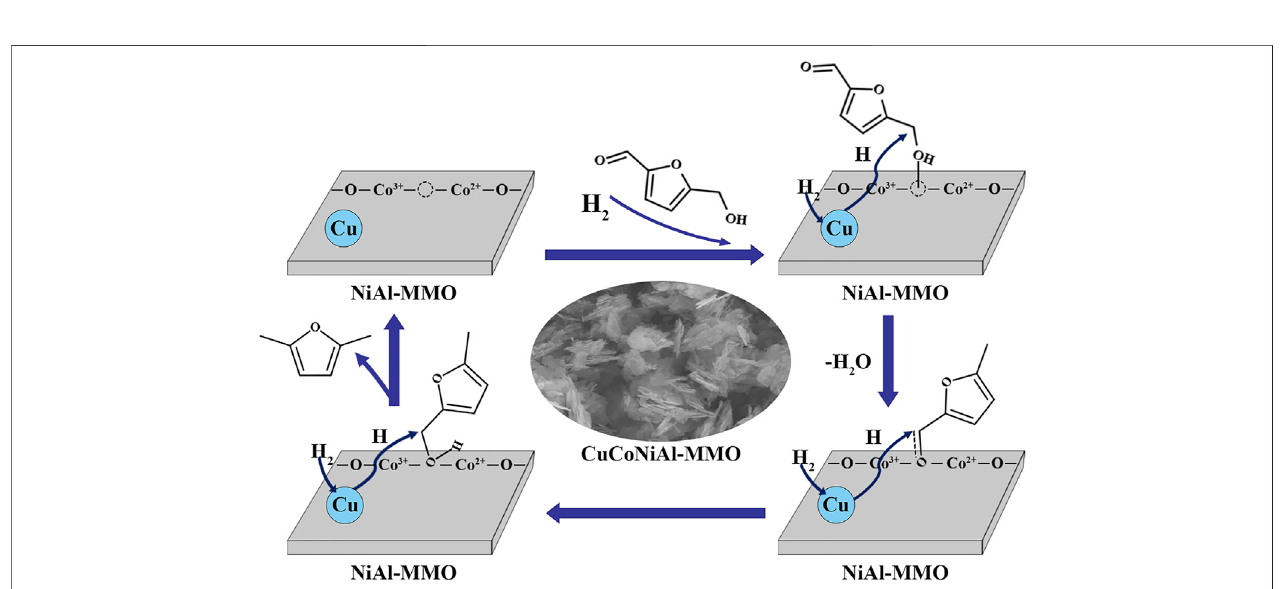
FIGURE 12 | Reaction mechanism for DMF formation by HMF hydrogenolysis on CuCoNiAl-MMO.